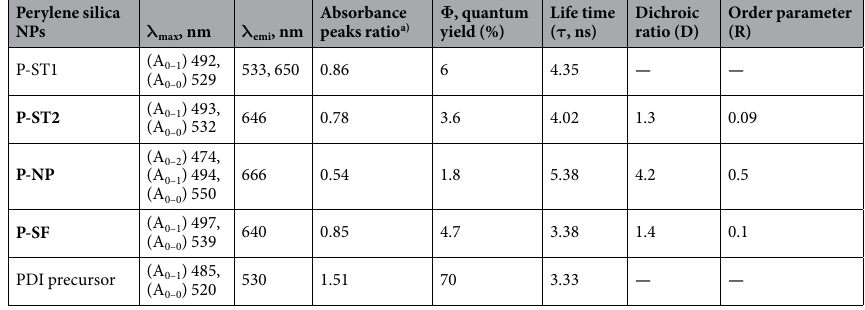
Table 1. Summary of photophysical properties of perylene silica nanoparticles. a) Peak-to-peak ratio of the absorbance at (0,